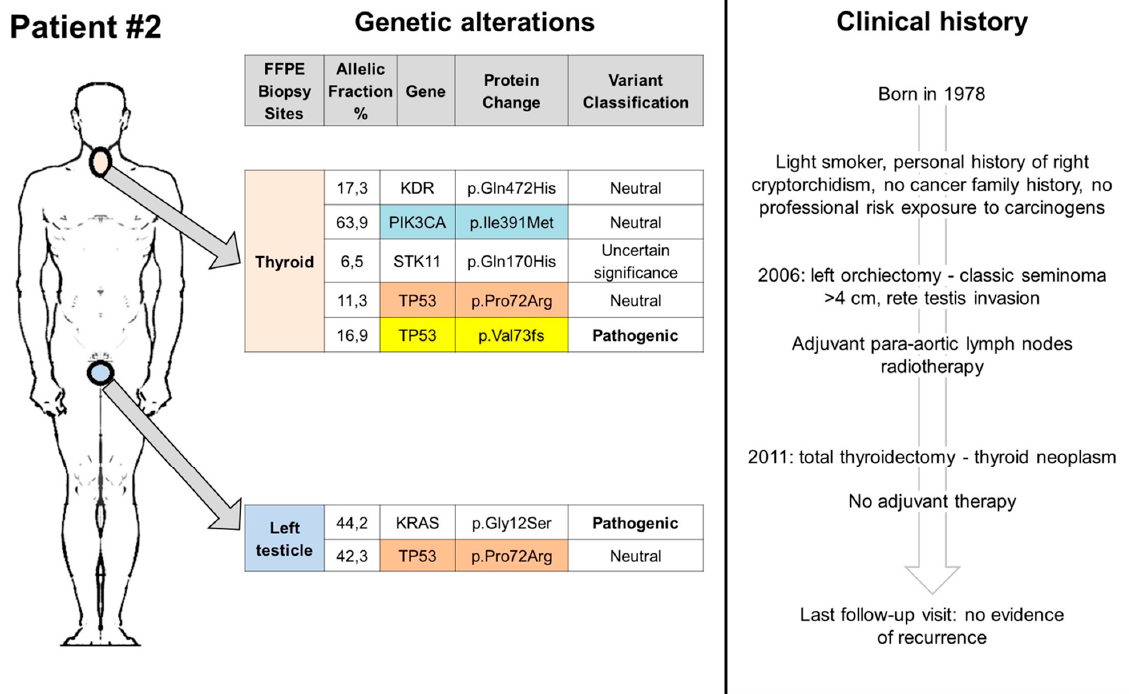
Figure 3. Clinical history and somatic genetic alterations of patient 2. FFPE: Formalin-Fixed Paraffin-Embedded.